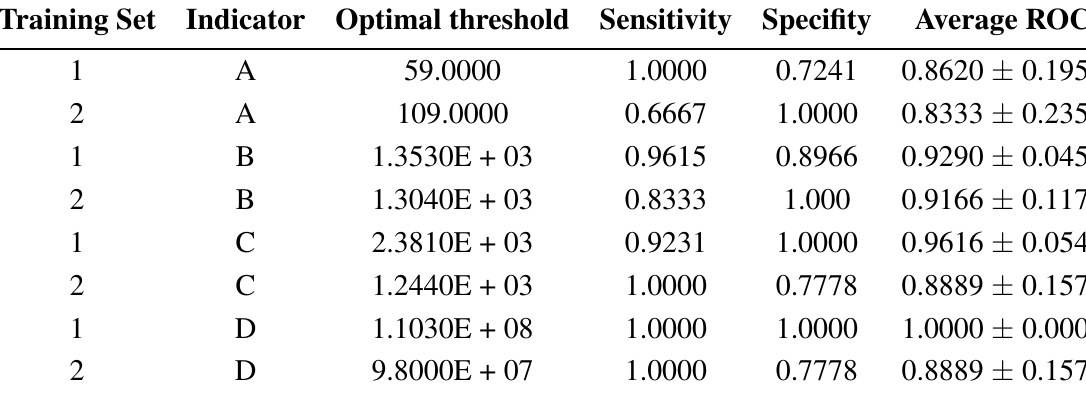
Table 2. Results of the test procedure of the Single-indicator Thresholding